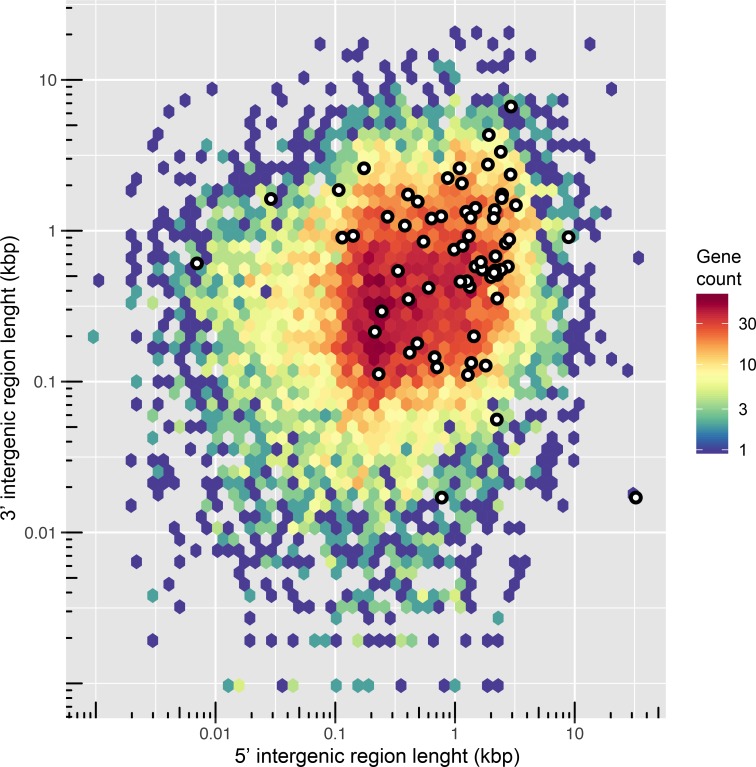
Genome spacing of predicted genes of Pfs1.The distance between neighbouring genes was depicted by plotting the 5′ and 3′ intergenic distances (on a log10 scale) for each if the 13,227 predicted genes. The scale bar represents the number of genes in each bin, shown as a color-coded hexagonal heat map in which red indicates a gene dense and blue a gene-poor region. The locations of putative Pfs effectors genes are indicated with white dots.